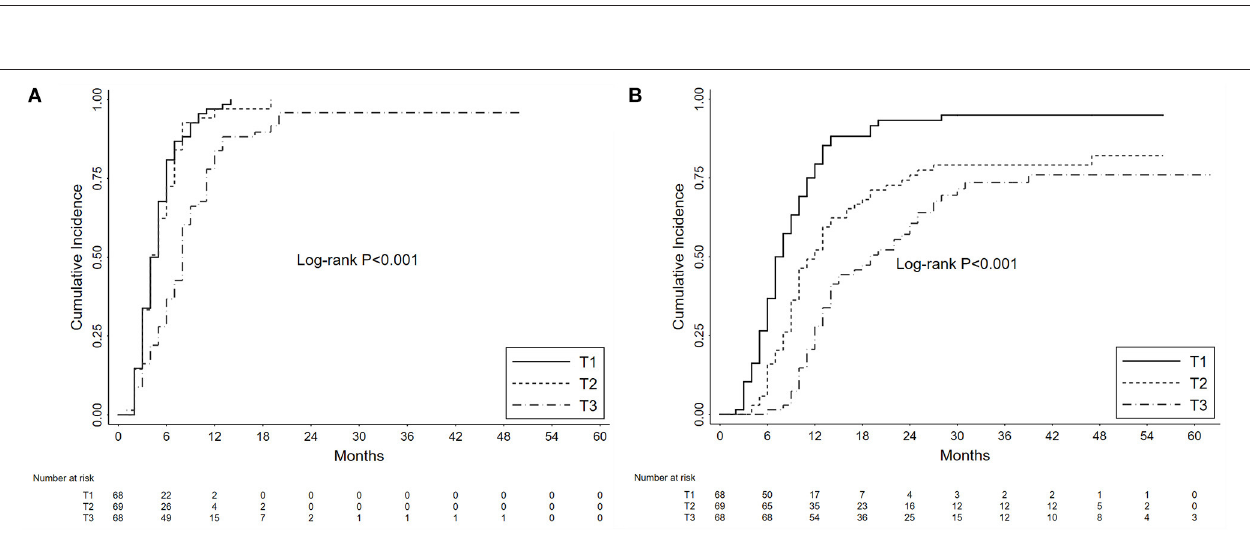
FIGURE 3 | Kaplan-Meier curves depict the cumulative probabilities of partial remission (A) and complete remission (B) for patients with primary membranous nephropathy and subnephrotic range proteinuria. The patients were grouped by the tertiles (T1 vs. T2 vs. T3) of initial proteinuria. The time zero was a kidney biopsy. Log-rank tests were used for the comparison between groups.